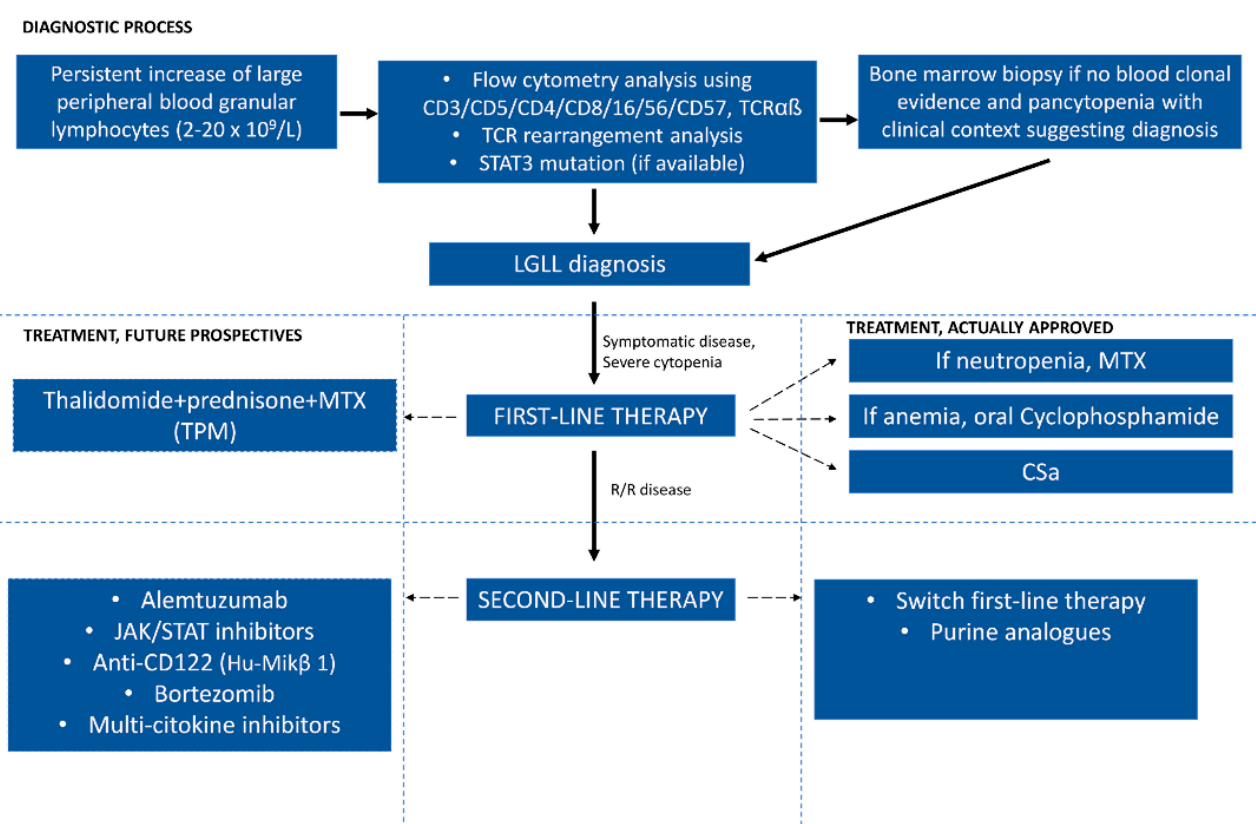
Figure 5. Diagnostic criteria and treatment options in LGL leukemia.